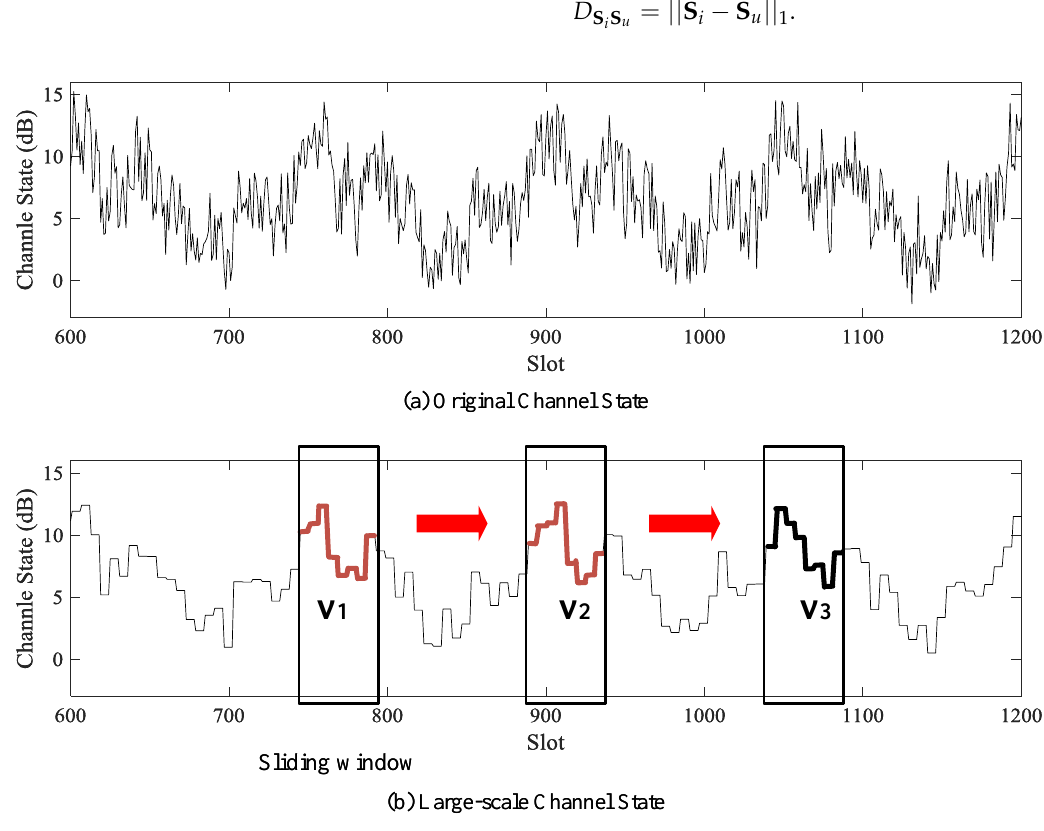
Figure 5. Channel state and large-scale channel state prediction method. ( a ) Original channel state. ( b ) Large-scale channel state and diagram of k -nearest neighbor algorithm with sliding window. v 3 is the test vector. v 1 and v 2 are nearest neighbors chosen from training